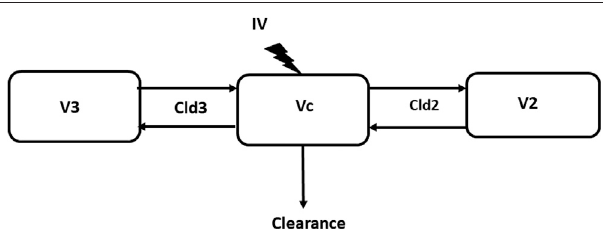
FIGURE 1 | The 3-compartmental model. Vc, V2, and V3 are the volumes of distribution of the central, super fi cial and deep peripheral compartments, respectively. Cld2 and Cld3 are the distribution clearance for the super fi cial and deep compartment,